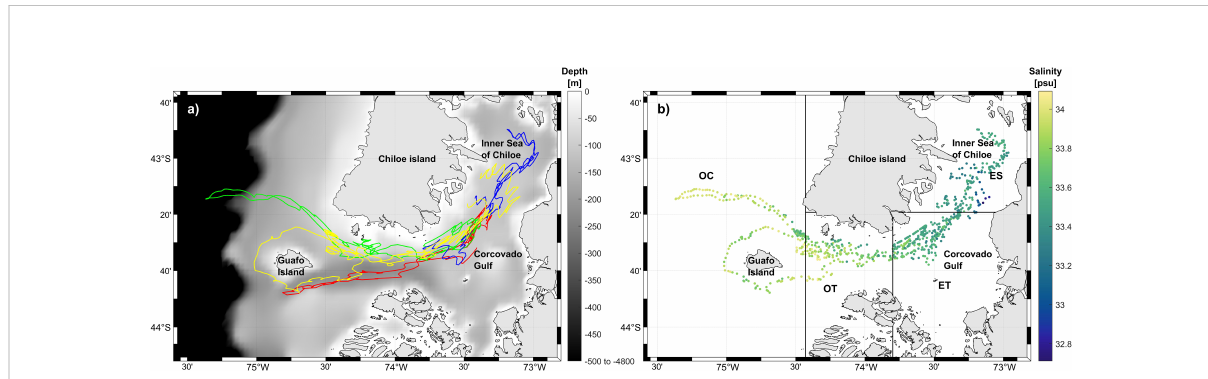
FIGURE 1 (A) Glider deployment tracks in 2018 and 2019 between the inner sea of Chiloe and Guafo Island. Red track: deployment 1, April 2018; green track: deployment 2, April 2019; blue track: deployment 3, April 2019; yellow track: deployment 4, May 2019. Grey scale: bathymetry from Instituto de Fomento Pesquero (IFOP; (Pinilla et al., 2020)), Chile with depths ranging from 0 to -4800 m (B) Map of deep layer salinity for 2019 deployments (d2, d3 and d4) throughout the study area. ES, Estuarine zone; ET, Estuarine Transition zone; OT, Oceanic Transition zone; OC, Oceanic